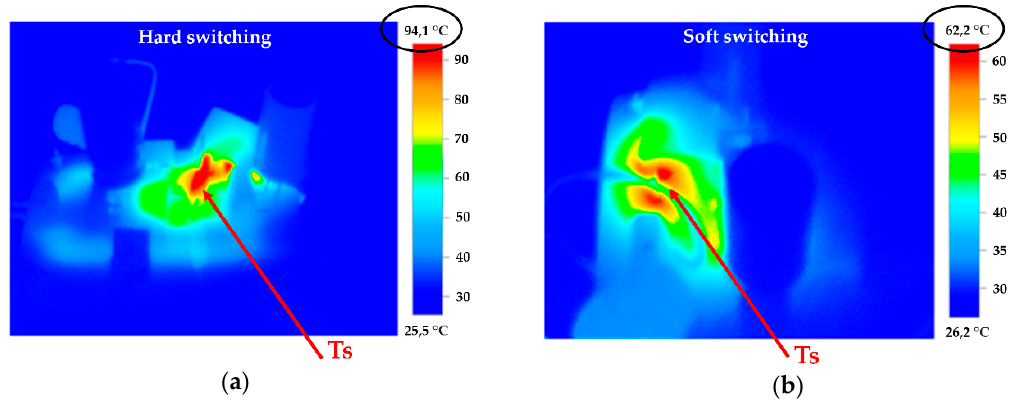
Figure 30. Comparing the heated Flayback converter during ( a ) hard switching; ( b ) soft switching.